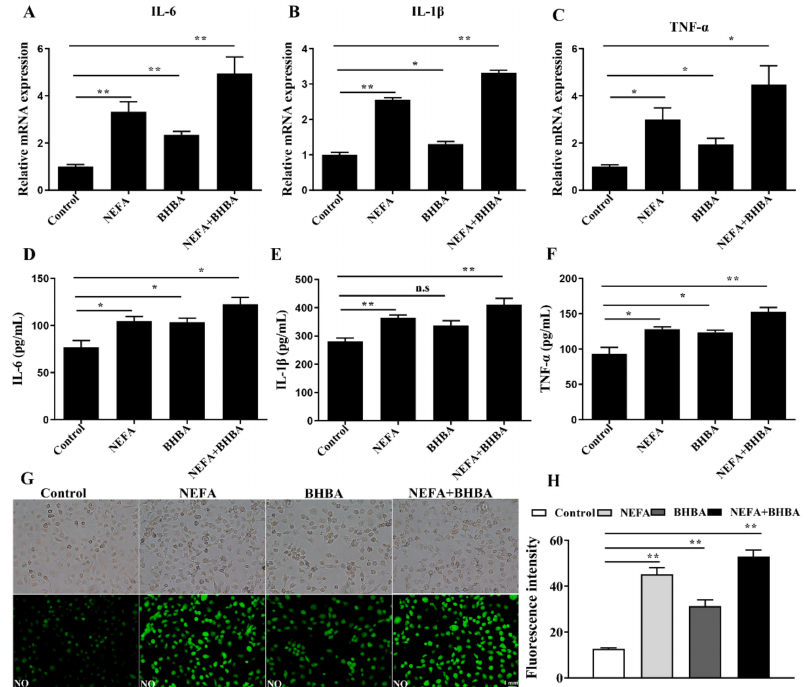
Figure 4. NEFA and BHBA treatment induced inflammatory response in BMECs. ( A – C ) qPCR analysis of TNF- α , IL-1 β , and IL-6 in BMECs treated with NEFA and BHBA. ( D – F ) ELISA analysis of IL-1 β , IL-6, and TNF- α in BMECs treated with NEFA and BHBA. ( G ) Immunofluorescence staining of NO in BMECs. ( H ) Green fluorescence intensity of NO was quantified by Image J. Data are presented as the means ± SEM of three independent experiments. * p < 0.05; ** p < 0.01; n.s. means not